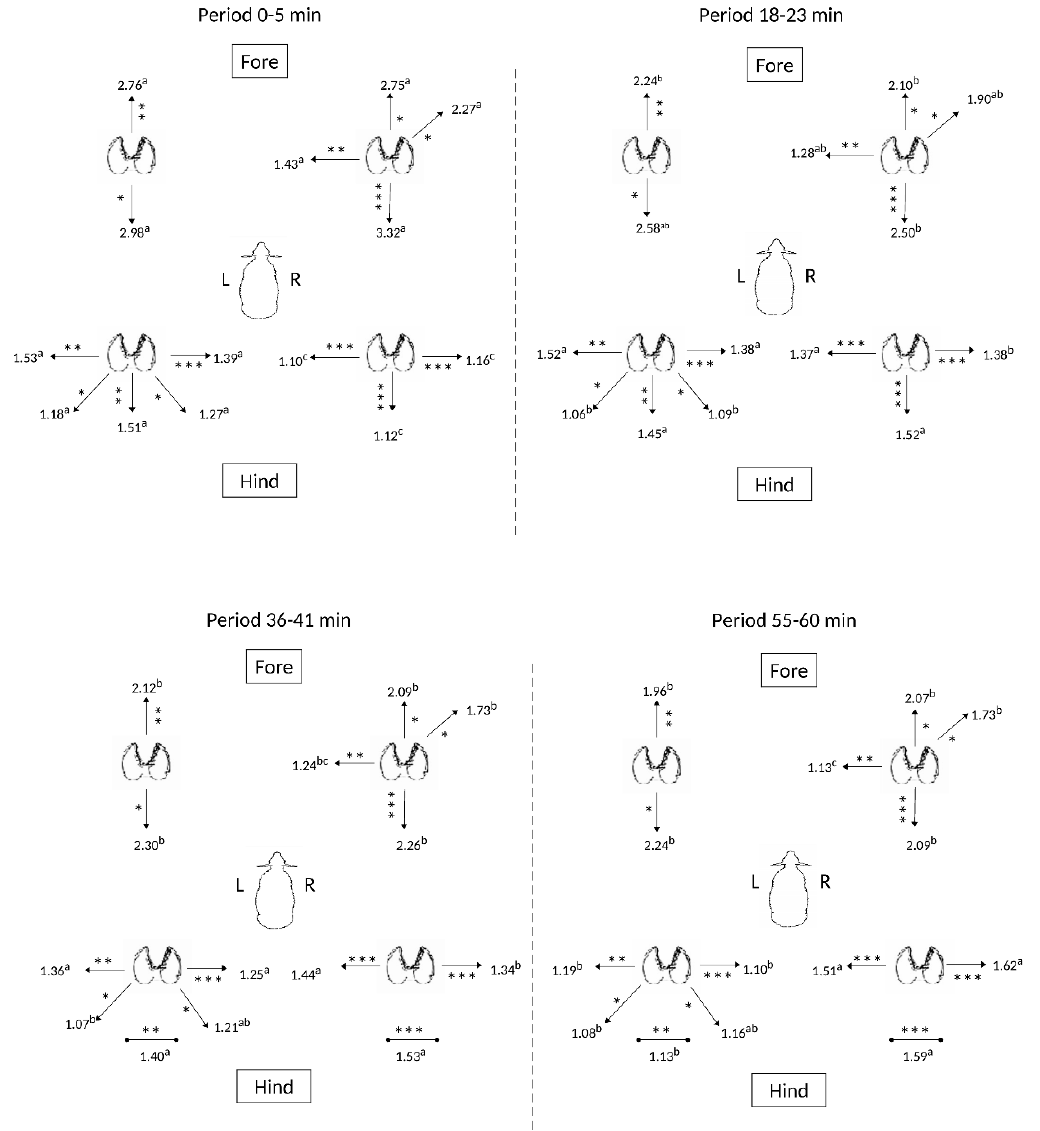
Figure 5. E ff ects of time within the hour’s exposure on the movements (steps / 20 min) of the four limbs of sheep ( n = 6). Directions for significant di ff erences in stepping frequency observed for each respective Figure 5. Effects of time within the hour’s exposure on the movements (steps/20 min) of the four limbs limb are presented (* p < 0.05; ** p < 0.02; *** p < 0.001). Di ff erent superscript letters (a,b,c,d,e,f) denote of sheep ( n = 6). Directions for significant differences in stepping frequency observed for each significantly di ff erent responses ( p < 0.05) observed for each individual respective limb are presented (* p < 0.05; ** p < 0.02; *** p < 0.001). Different superscript letters (a,b,c,d,e,f) denote significantly different responses ( p < 0.05) observed for each individual limb.